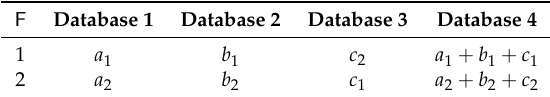
Table 7. Answers for W 3